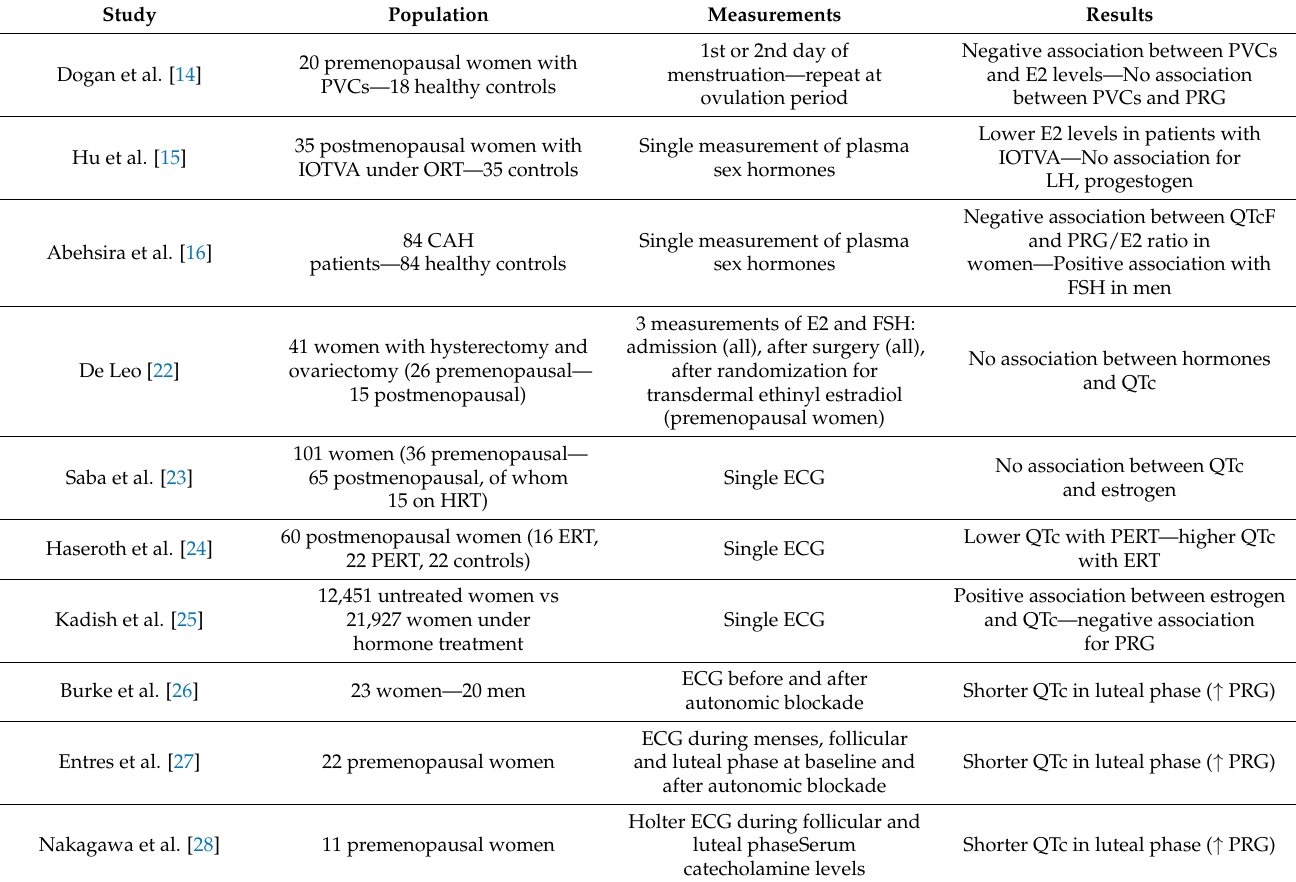
Table 3. Major studies on the association between hormone levels and electrocardiographic changes.